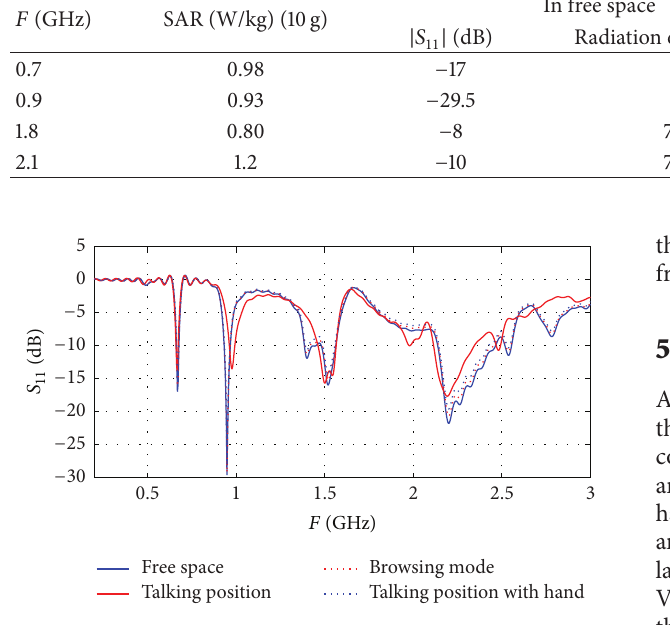
Figure 9: The simulated return loss of antenna in mobile handset in four different test positions.